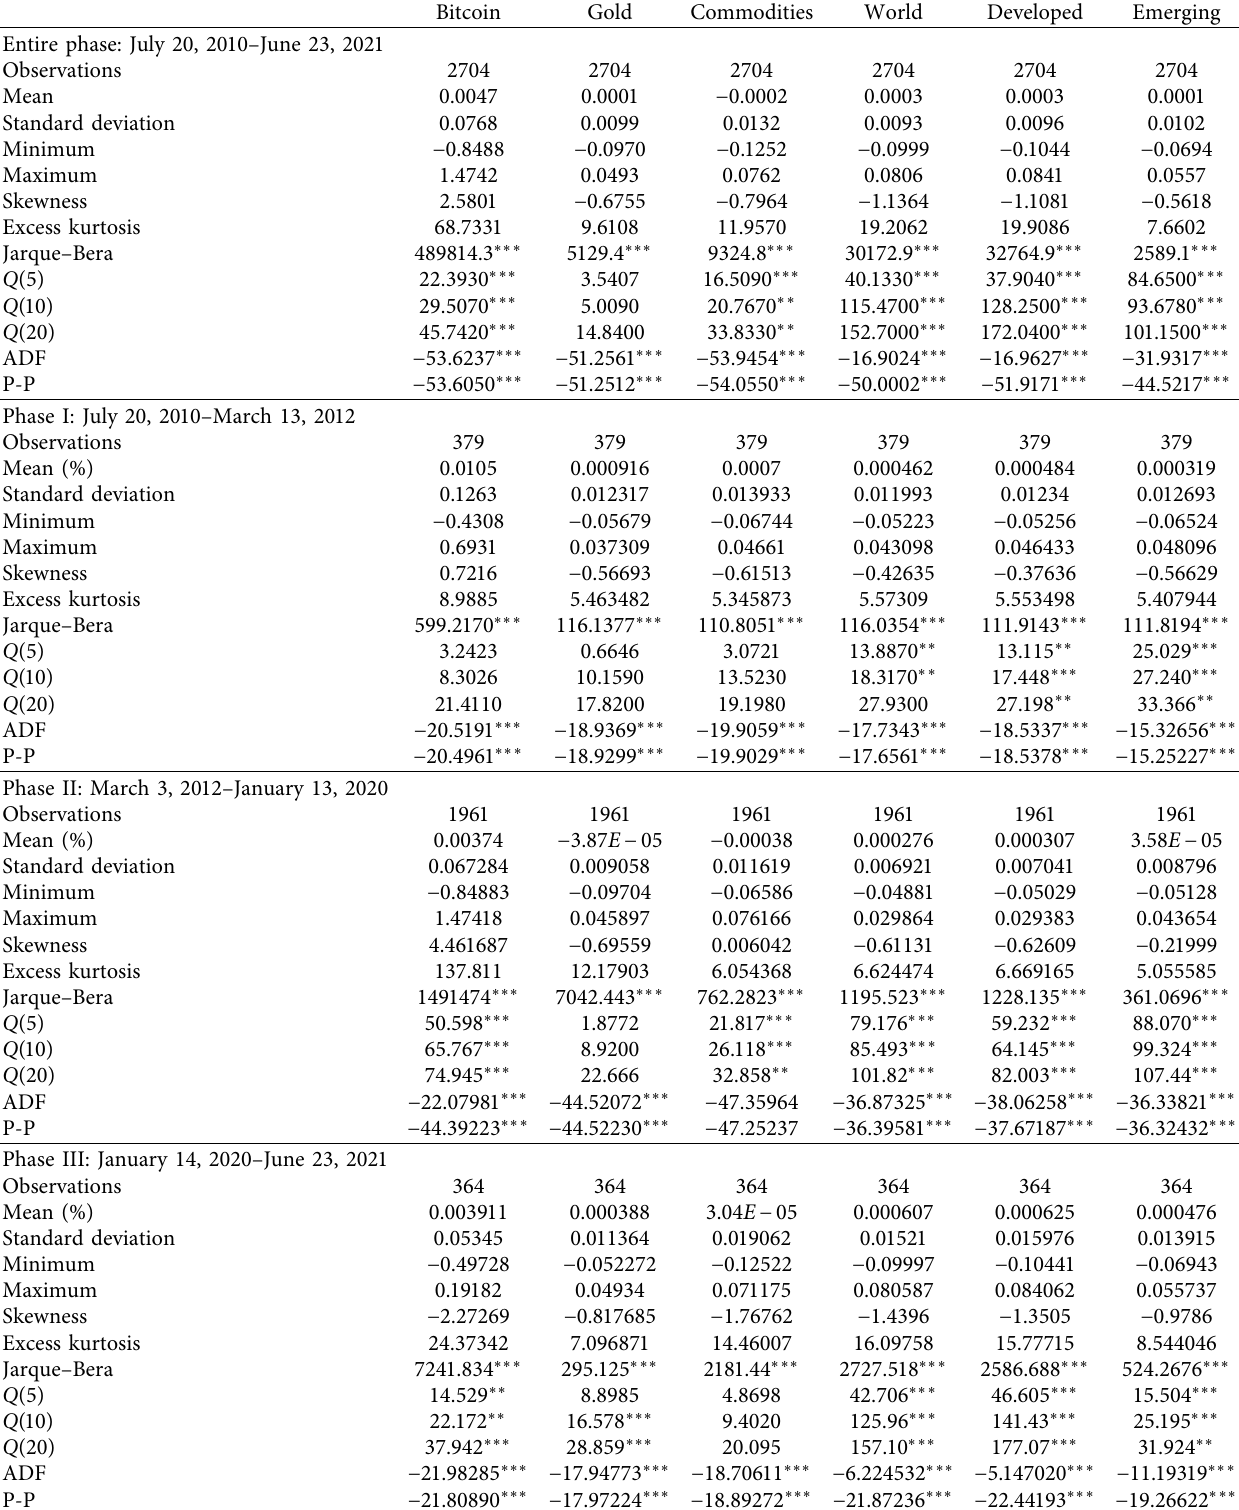
Table 1: Descriptive statistics of all return